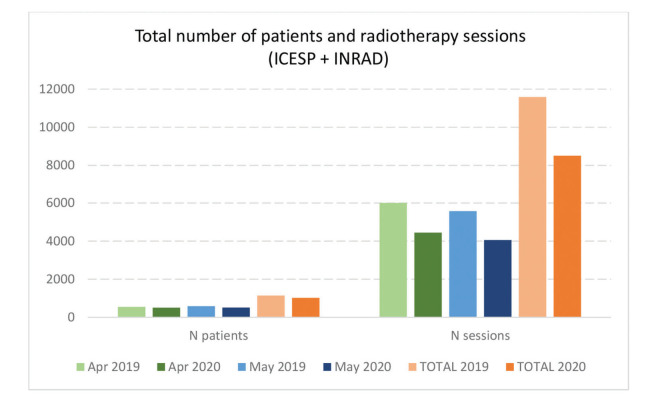
Total number of patients treated and the corresponding number of sessions in April and May 2019, compared to those in April and May 2020.